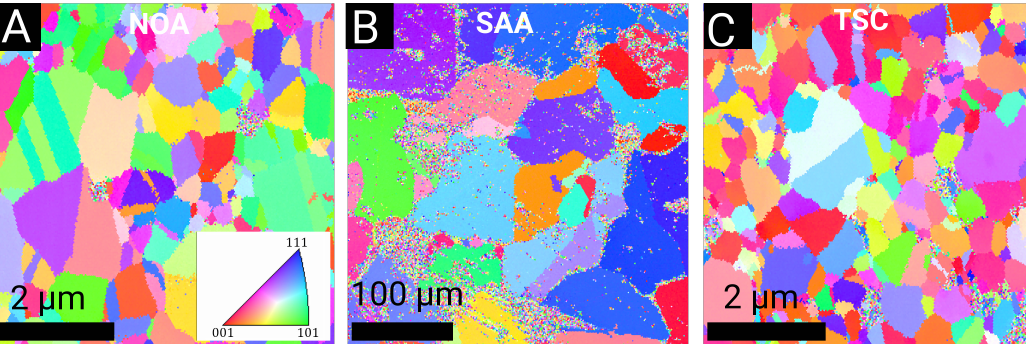
Figure 5. EBSD orientation maps for samples NOA ( A ), SAA ( B ), and TSC ( C ) annealed up to 1000